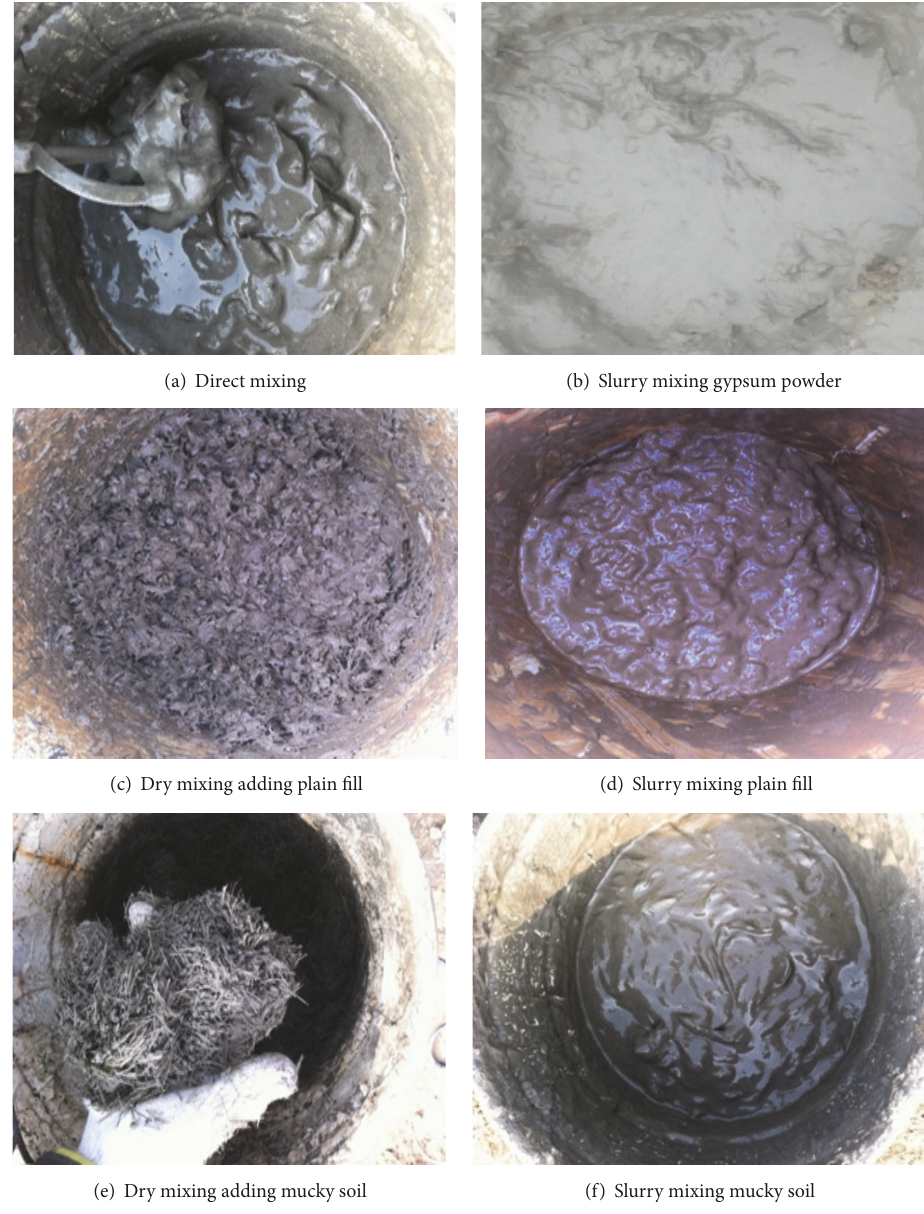
Figure 13: The mixing effect of the slurry blender with different